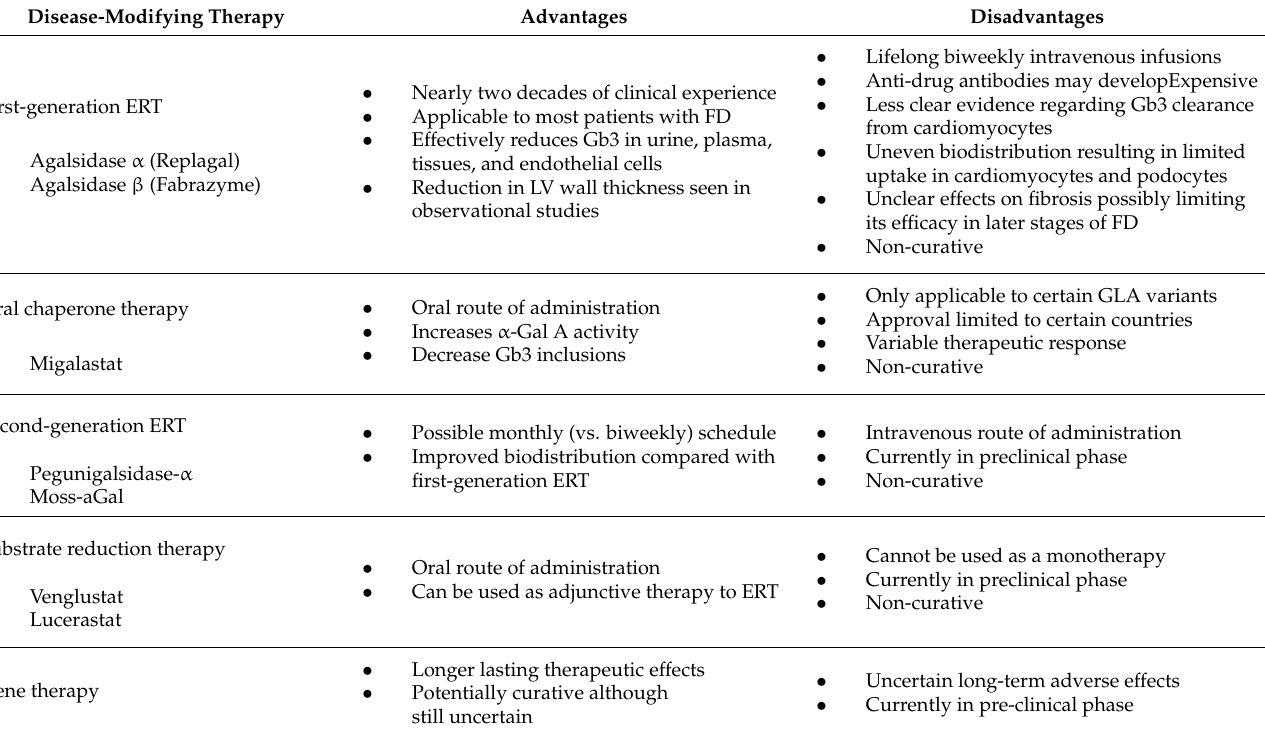
Table 3. Comparison of approved and investigational disease-modifying therapies for Fabry